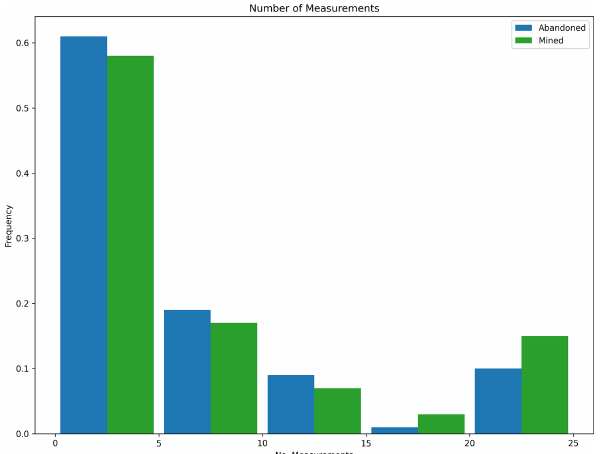
Figure 15. Measurement histogram, POMCPOW with action con- straints, single body with fixed location. This figure shows a his- togram of the number of measurements taken by the POMCPOW solver over all Monte Carlo trials. The trials were limited to a max- imum of 25 measurements.